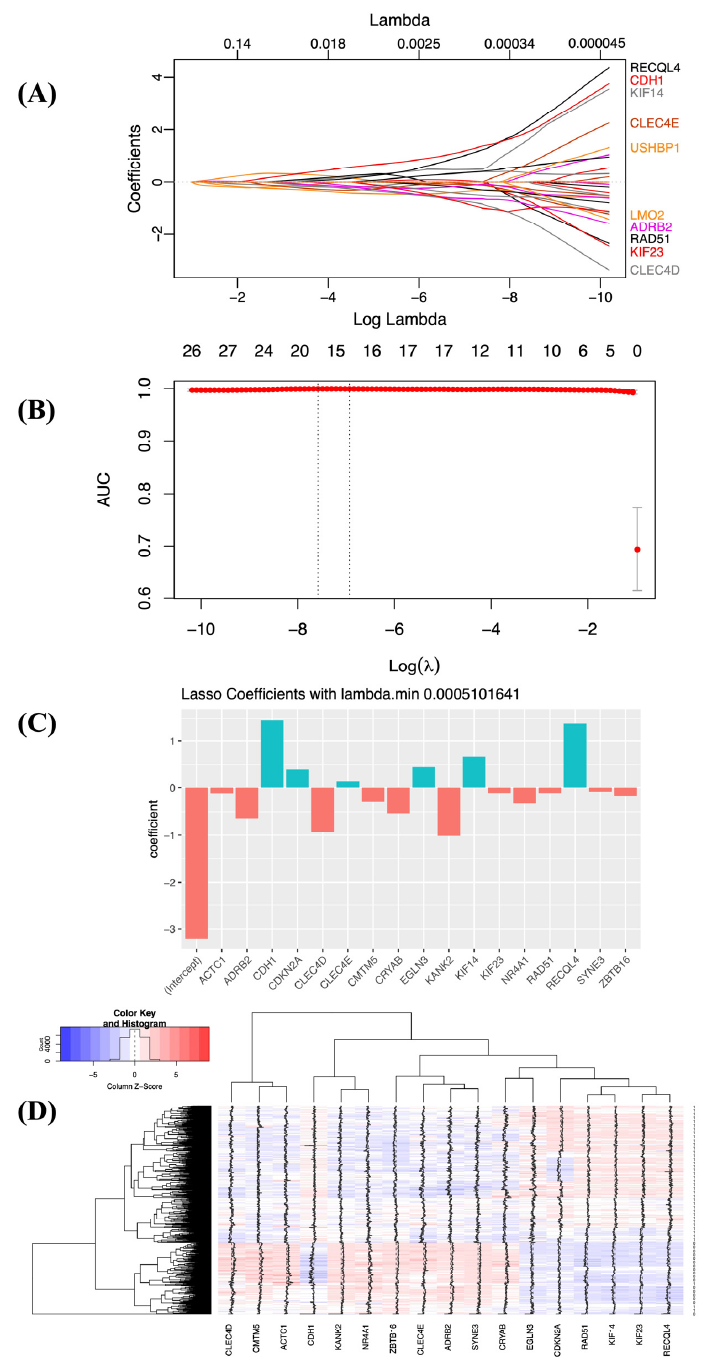
Figure 3. Construction of the risk score model for lung cancer prediction using LASSO logistic regression with 10-fold cv using glmnet . ( A ) LASSO regression coefficient profiles of 40 genes associated with lung cancer at different values of log lambda. Each curve indicates a gene and the path of its coefficient against the different values of log lambda. ( B ) This plot displays the AUC value (in red) with varying values of log lambda. The vertical dotted line at the left indicates the value of λ lambda.min that gives the maximum average AUC. The vertical dotted line at the right shows the largest value of λ lambda.1se; the performance is within one standard error of the maximum average AUC. The numbers across the top are the nonzero coefficient estimates. ( C ) Bar graph representing the regression coefficients for the most relevant genes (17 genes) at lambda.min = 0.0005101641. The blue- green bar represents positive coefficients; the red bar represents negative coefficients. ( D ) Heatmap of the expression patterns of relevant genes (17 genes) from the TR